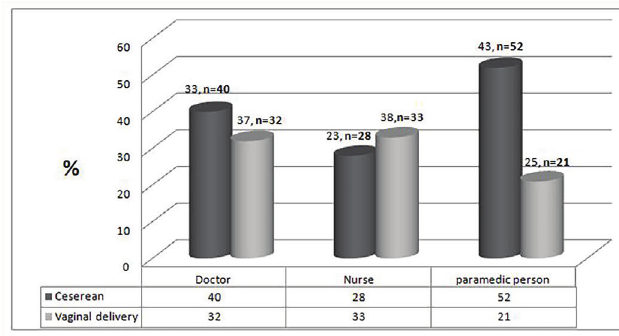
Figure 3 -Comparison of the first delivery method according to profession